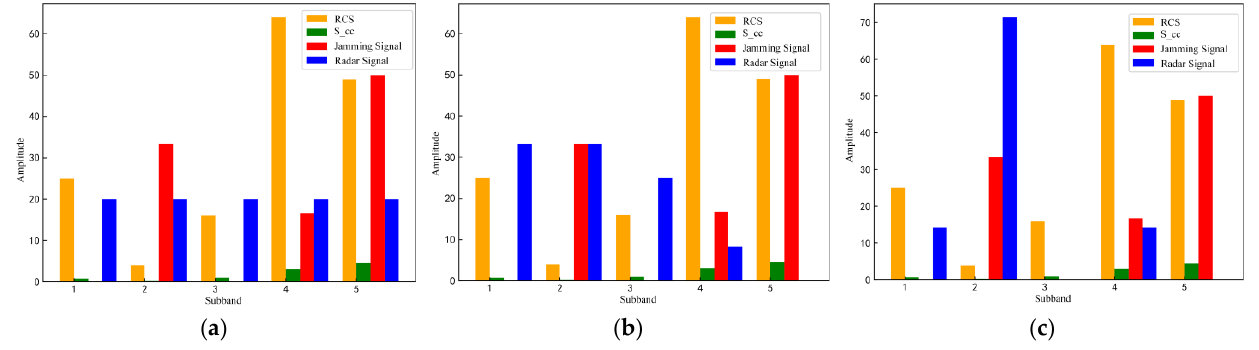
Figure 10. Three radar-transmitted signals under jamming conditions. ( a ) linear frequency modula- tion (LFM) signal; ( b ) anti-jamming signal generated based on policy iteration method; ( c ) radar optima anti-jamming signal generated based on D3QN.